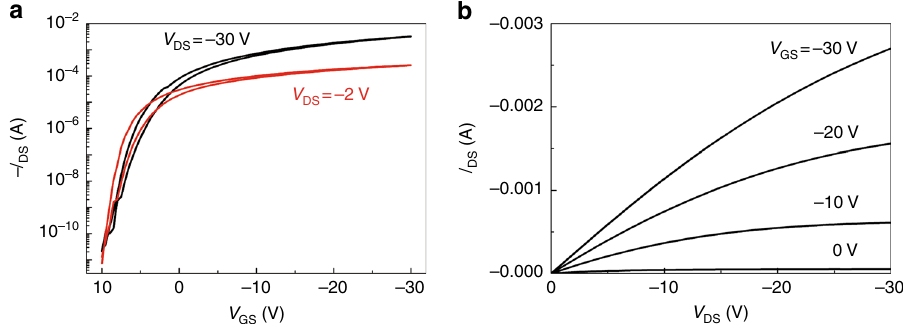
Fig. 3 Device performance of PffBT4T-2DT PoM-FETs. a Transfer and b output characteristics of PffBT4T-2DT PoM-FET with co-centric ring geometry. The channel length and width are 10 and 2500 μ m, respectively. The drain voltages used in ( a ) are − 2 and − 30 V for the measurement in the linear and saturation regimes,